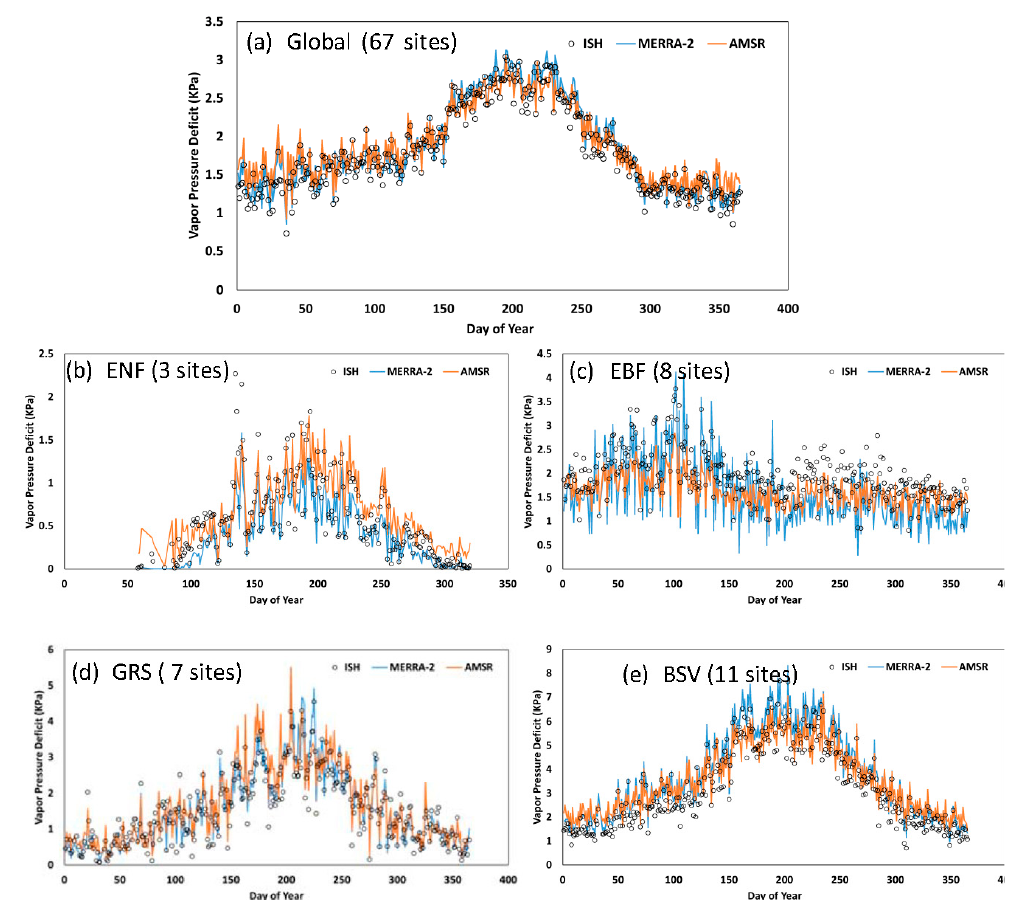
Figure 4. Afternoon (~1:30 p.m. local time) site-averaged Vapor Pressure Deficit (VPD) time series derived from respective the Advanced Microwave Scanning Radiometer (AMSR) Land Parameter Data Record (LPDR) outputs, the Modern-Era Retrospective analysis for Research and Applications, Version 2 (MERRA-2) reanalysis and Integrated Surface Global Hourly (ISH) in-situ measurements over ( a ) the globe and for major land cover types, including ( b ) evergreen needle leaf forest (ENF), ( c ) evergreen broadleaf forest (EBF), ( d ) grassland (GRS), and ( e ) barren to sparsely vegetated land (BSV) land areas over 2010.